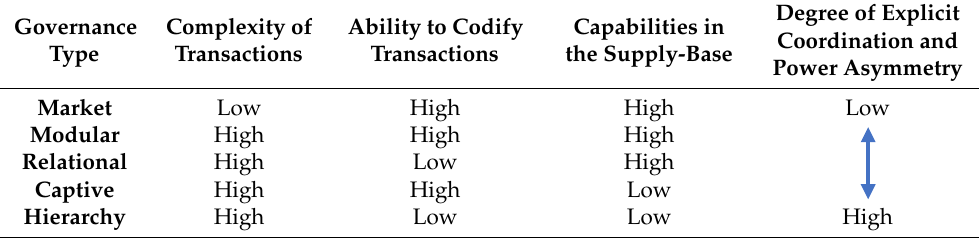
Table 1. Key determinants of global value chain governance.